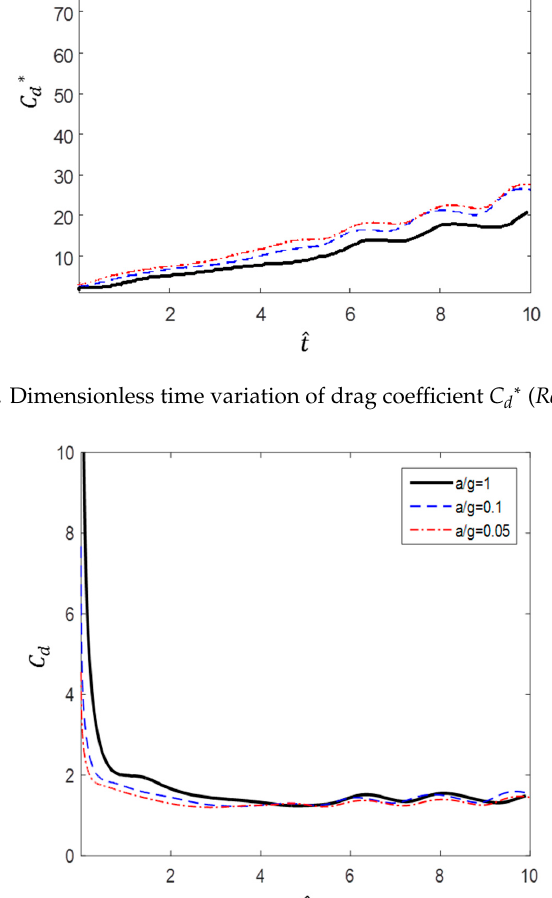
Figure 23. Dimensionless time variation of drag coe ffi cient C d ( Re 0 = 1000).